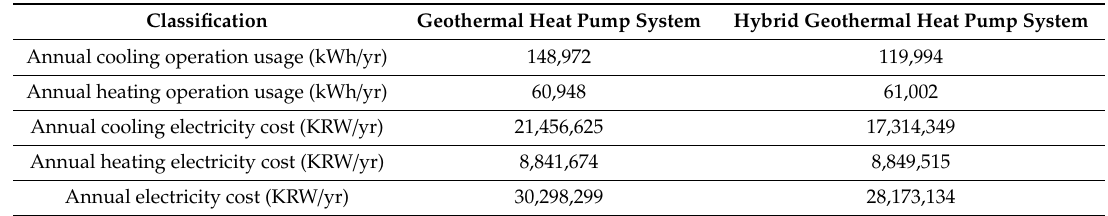
Table 9. Annual electricity usage and cost.